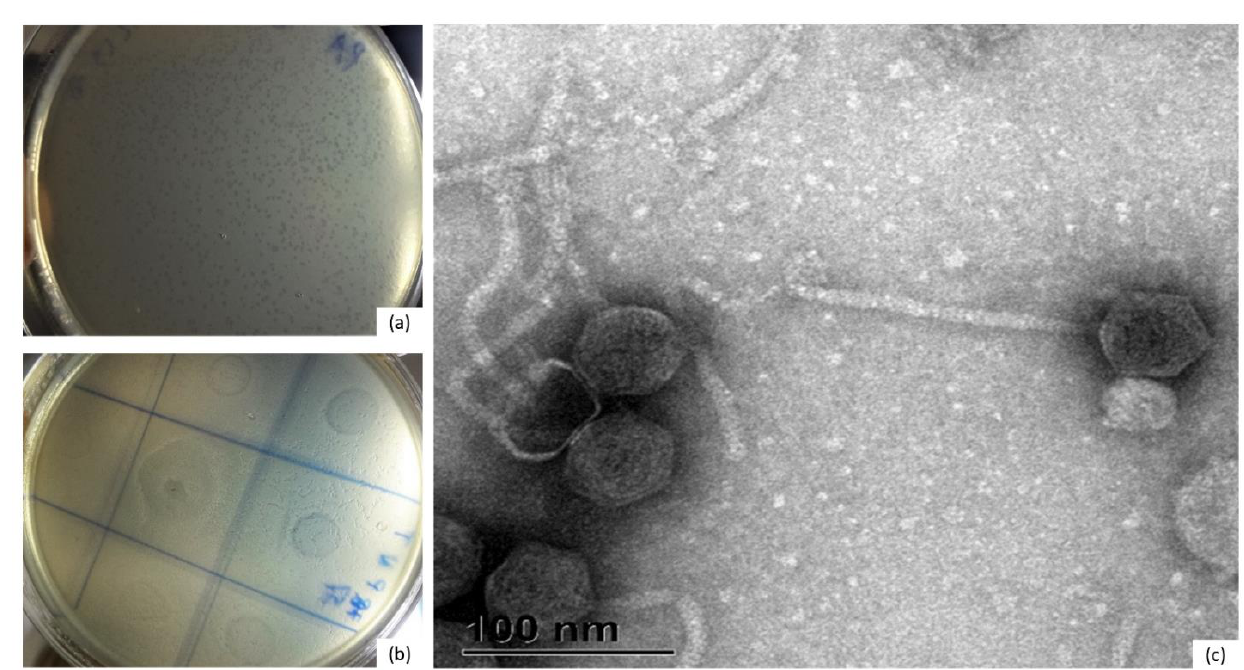
Figure 1. Bacuni phages exhibit Siphoviridae morphology. ( a ) Plaque morphology of Bacuni phage F1 formed on B. uniformis MB18-33 host lawn after 24 h incubation in sABB agar overlay. ( b ) Lysis-like zones formed on sABB agar overlay after 24 h incubation with host strain B. vulgatus MB18-32 in double layer agar overlay (spot assay with enrichment sample). ( c ) Photograph of Bacuni virion obtained by transmission electronic microcopy (scale bar is 100 nm).